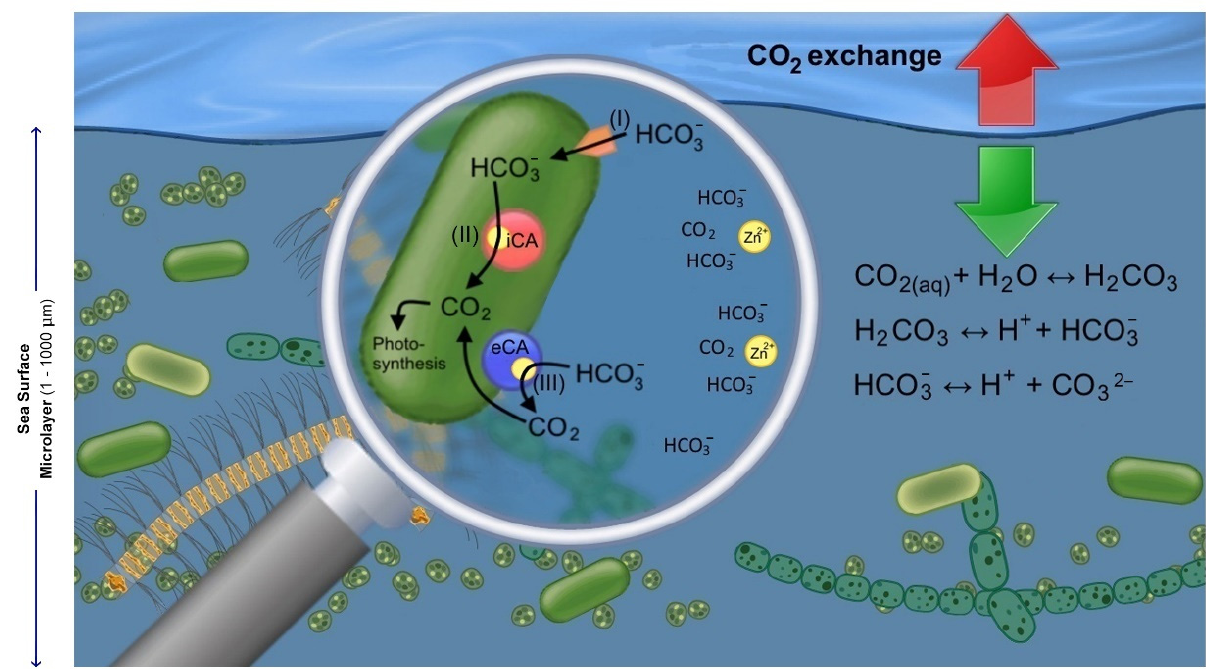
Figure 1. The role of extracellular (eCA) and internal carbonic anhydrase (iCA) in the sea surface microlayer (SML). Equations are given for the hydration of CO 2 . (i) Alternative carbon acquisition through direct uptake of HCO 3 − . (ii) Internal conversion of HCO 3 − to CO 2 by iCA. (iii) Catalytic conversion of HCO 3 − to CO 2 by eCA within the cell’s diffusive layer, and CO 2 diffusion through the cell’s membrane.